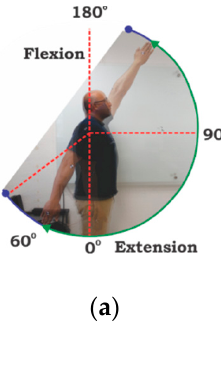
Figure 1. Movements of: ( a ) flexion–extension; ( b ) abduction–adduction of the arm (from that angle approximately, an additional DOF is made to reach 180°(cid:4667); ( c ) flexion–extension of the